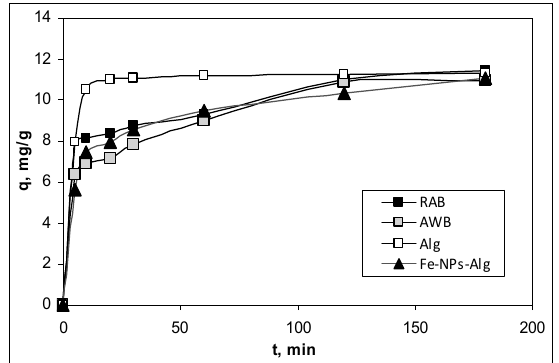
Figure 3. Influence of contact time on Cu(II) adsorption efficiency on considered adsorbent (initial pH = 4.4; 2.0 g adsorbent / L, c 0 = 25.41 mg Cu(II) / L, temperature = 25 ◦ materials (initial pH = 4.4; 2.0 g adsorbent/L, c 0 = 25.41 mg Cu(II)/L, temperature = 25 ° C).